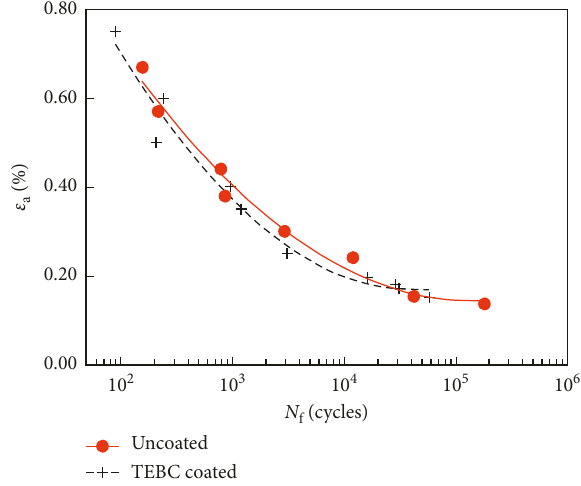
Figure 6: Fatigue life curves of TEBC-coated and uncoated MAR- M247